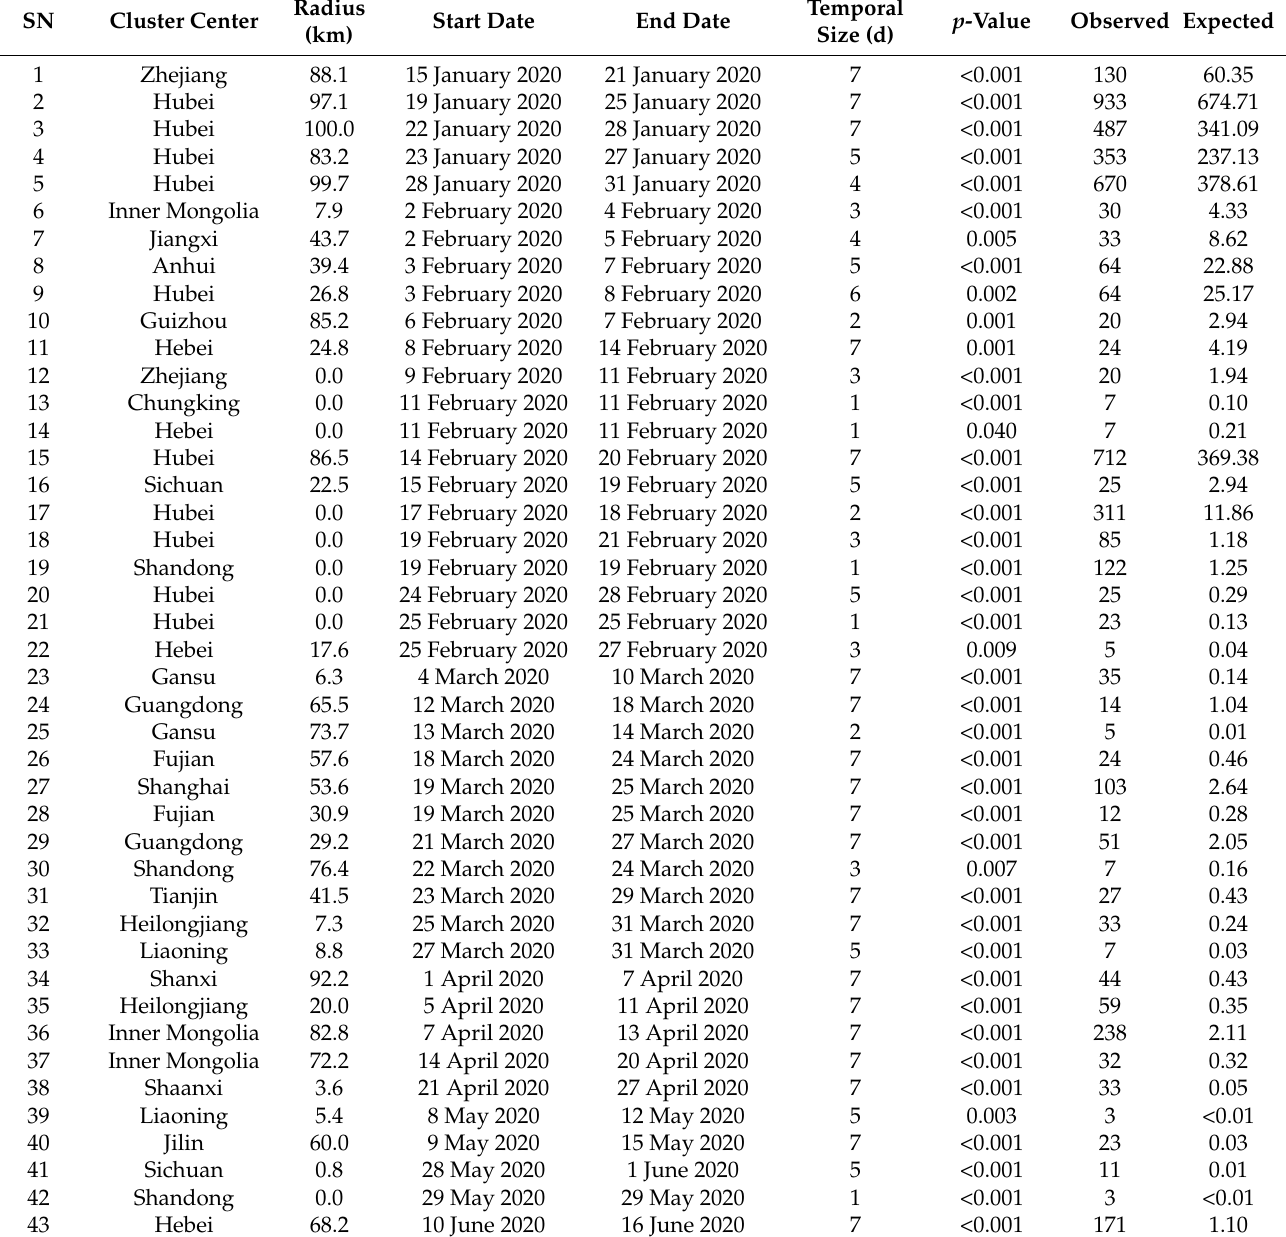
Table 1. Characteristics of the statistically significant space-time clusters of COVID-19 at the family-level with a maximum spatial scanning window size of 100 km in mainland China from 2 December 2019 to 20 June 2020 (clusters where all cases happen in the same geolocation are reported as having 0 km